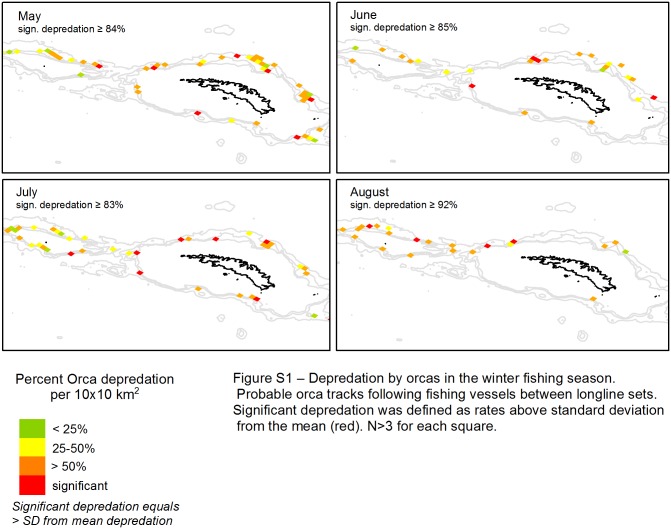
Depredation by orcas in the winter fishing season.Percent depredation (% CPUE difference between depredated and non-depredated lines) per 10 km2 for each month of the winter fishing season. Significant depredation was defined as rates above standard deviation from the mean (red). Each square represents 10 km2. N>3 for each square.